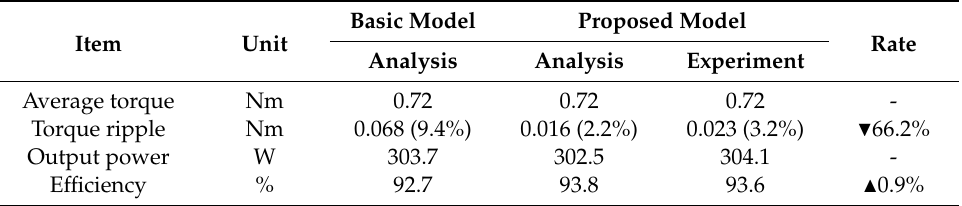
Figure 18. Experimental characteristics at rated load test (at 4020 rpm) and enlarged torque ripple waveform. Table 10. Comparison of the basic model and the prototype